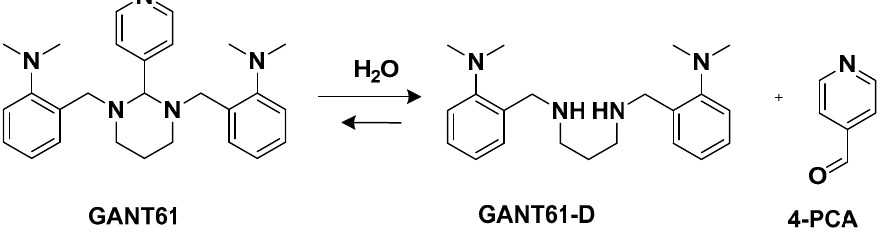
Figure 5. GANT61 hydrolysis releasing GANT61-D and 4-PCA. Two trans -[Pt(II)Cl 2 (dmso)L]-type complexes, 7 and 8 , where L represents both GANT61 and 4-PCA, have also been synthesized (Figure 6).